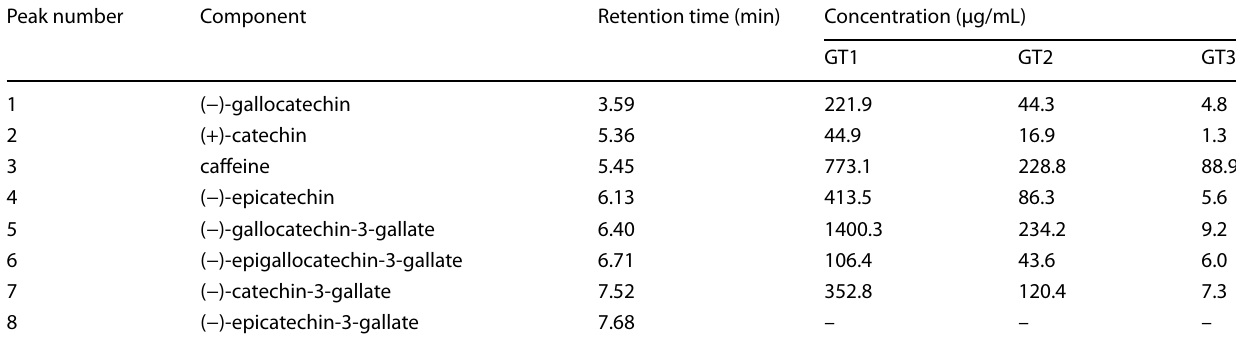
Table 2 Catechin profile of green tea samples obtained at three subsequent extraction rounds Peak